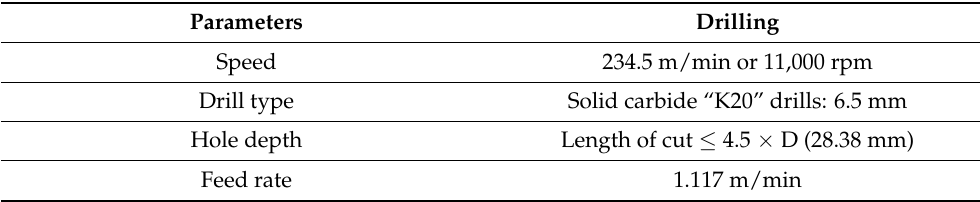
Table 3. Cutting parameters applied for machinability